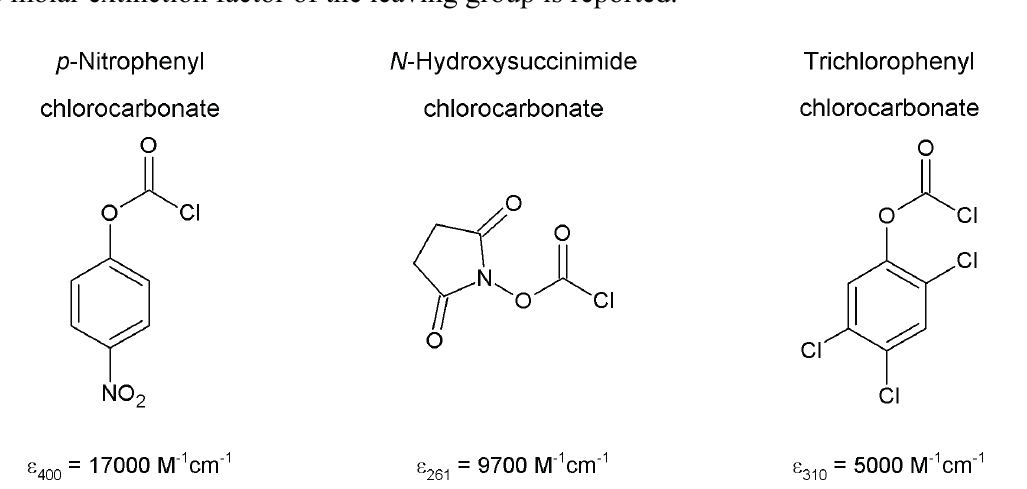
Figure 6. The most used chlorocarbonates for the activation of hydroxyl-bearing supports. The molar extinction factor of the leaving group is